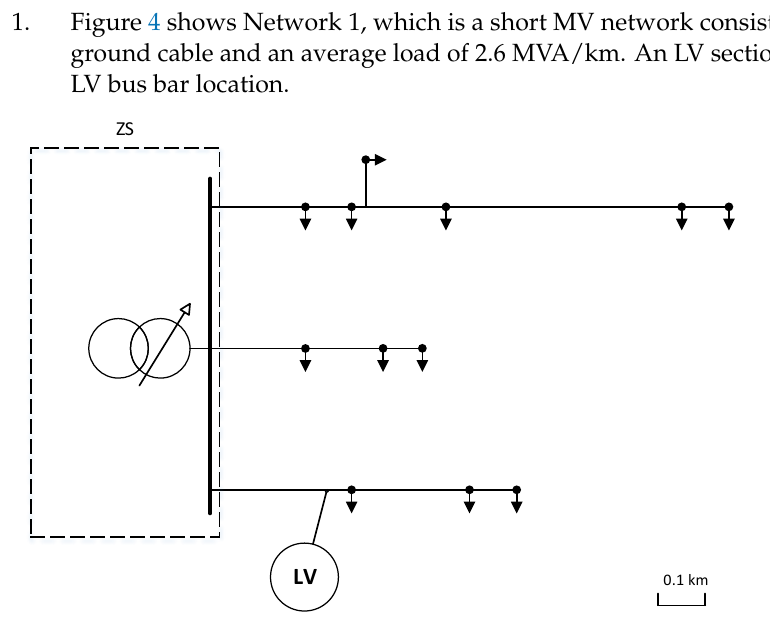
Figure 4. Network 1 [27].